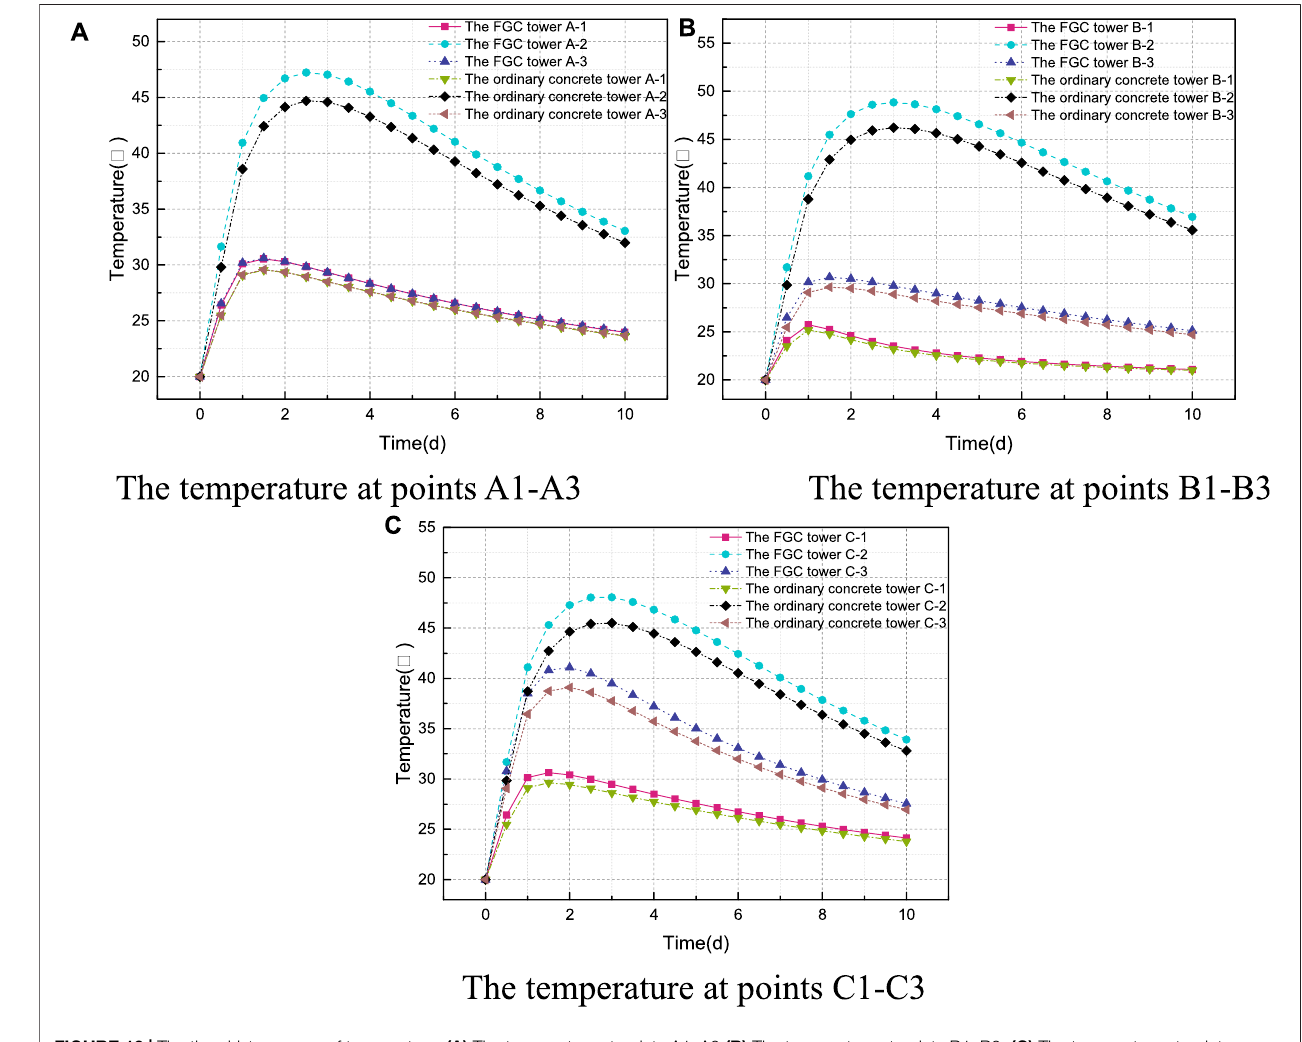
FIGURE 13 | The time-history curve of temperature. (A) The temperature at points A1 – A3 (B) The temperature at points B1 – B3. (C) The temperature at points C1 – C3.